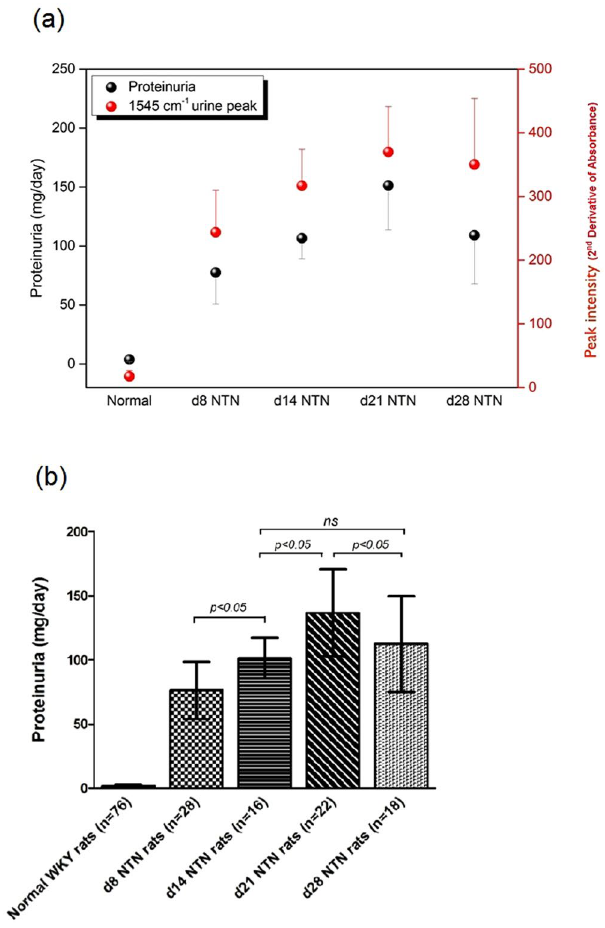
Figure 7. ( a ) The urinary 1545 cm − 1 mid-infrared marker had a positive correlation with proteinuria during the time course of NTN. ( b ) Although the level of proteinuria increased gradually along with progression of nephritis, there was a manifest sudden drop at d28 NTN ( p < 0.05) probably caused by a fall in glomerular filtration rate due to severe renal